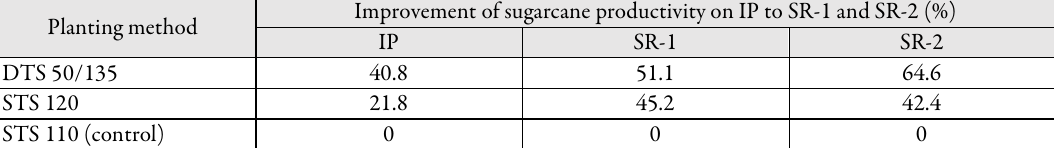
Table 4. Percentage of sugarcane productivity improvement in IP, SR-1 and SR-2 (%) Planting method